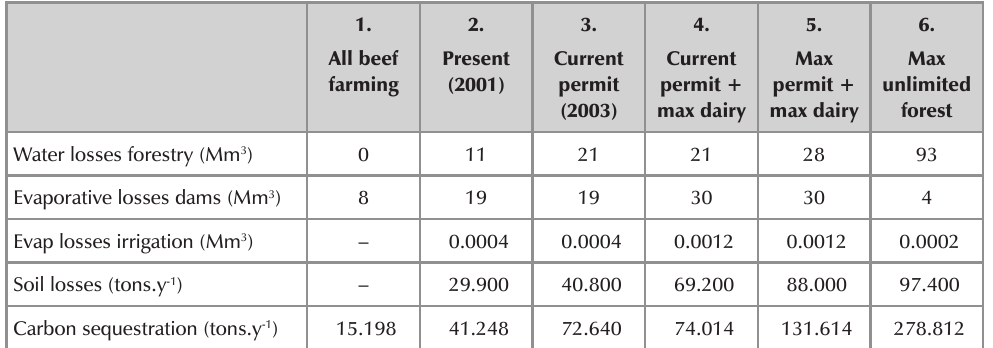
Physical impacts of different land use scenarios for Underberg